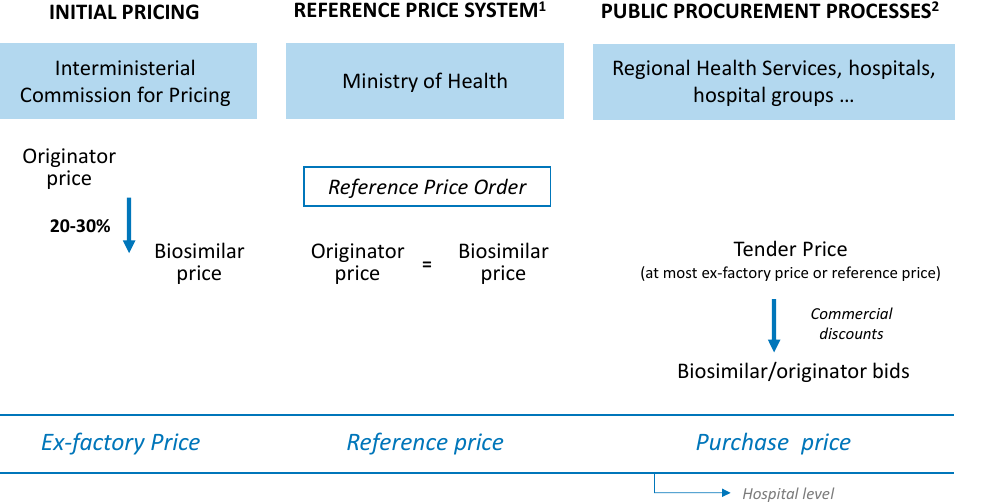
Figure 1. Price regulation of biosimilar medicines in Spain. 1 According to Royal Decree 177/2014, of 21 March, regulating the reference price system and the system of homogeneous groups of medicinal products in the National Health System. 2 According to Law 9/2017 of 8 November on public sector contracts.